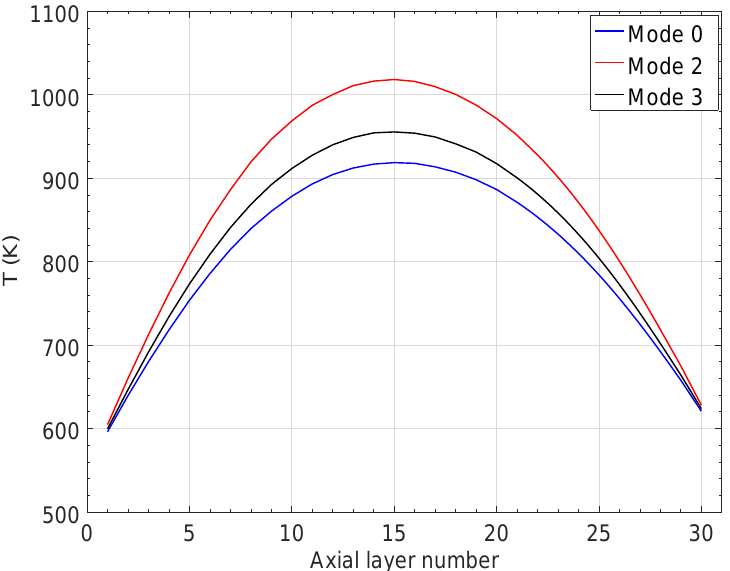
Figure 3: Fuel Centreline Temperature Profile in Rod 2